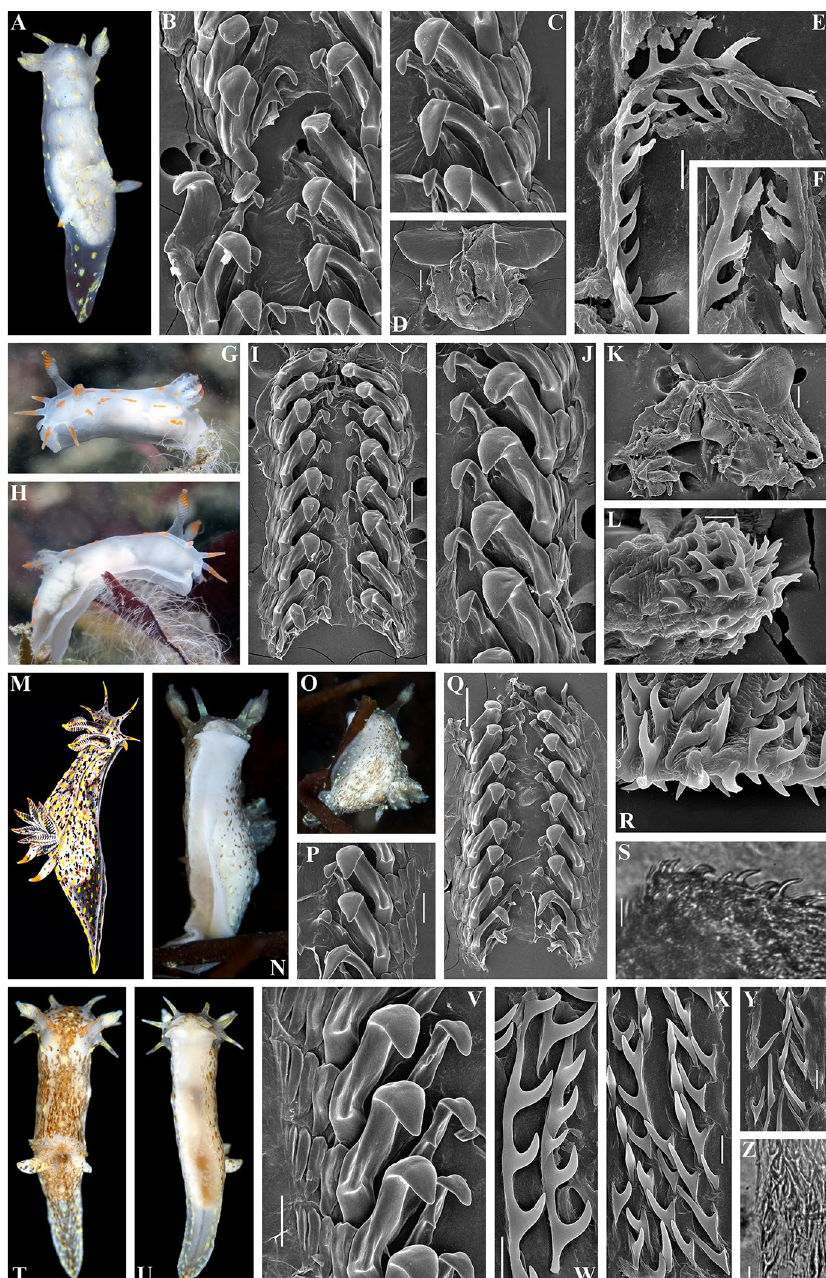
Figure 7. Polycera capitata (Alder & Hancock, 1854) 49 . External and internal morphology, light and scanning electron microscopy and comparison with data from Thompson and Brown 40 . ( A ) Specimen from United Kingdom, Cornwall, Porthkerris, dorsal view, live (ZMMU Op-766). ( B ) Radula, SEM (ZMMU Op-766). ( C ) Same, radula details. ( D ) Jaws, SEM. ( E ) Copulative spines, SEM (ZMMU Op-766). ( F ) Same, details. ( G ) Specimen from United Kingdom, Cornwall, Porthkerris, dorsal view, live (ZMMU Op-764). ( H ) Same, lateroventral view. ( I ) Radula, SEM (ZMMU Op-764). ( J ) Same, details. ( K ) Jaws, SEM (ZMMU Op-764). ( L ) Copulative spines, SEM (ZMMU Op-764). ( M ) Specimen from United Kingdom, Lundy Island, depicted in Thompson and Brown ( 40 : pl 18, c). ( N ) Specimen from United Kingdom, Cornwall, Porthkerris, ventral view, live (ZMMU Op-765). ( O ) Same, ventral view. ( P ) Radula, details, SEM (ZMMU Op-765). ( Q ) Radula (ZMMU Op-765). ( R ) Copulative spines, SEM (ZMMU Op-765). ( S ) Same, light microscopy. ( T ) Specimen from Ireland, Mullaghmore, Sligo, dorsal view (ZMMU Op-770). ( U ) Same, ventral view. ( V ) Radula, details, SEM (ZMMU Op-770). ( W – Y ) Copulative spines, details, SEM (ZMMU Op-770). ( Z ) Same, light microscopy. Scale bars: b–d, j, k, p, v—100 μm, i, q—200 μm, e, f, l, s, w–z—10 μm, r—5 μm. Photographs: F.M.F. Driessen (a), (g), (h), (n), (o); Bernard Picton (t), (u). Reproduction of figure from Thompson and Brown 40 with permission of Gregory Brown, original artist and copyright holder of the images. SEM micrographs and light microscopy photographs: Alexander Martynov, Tatiana